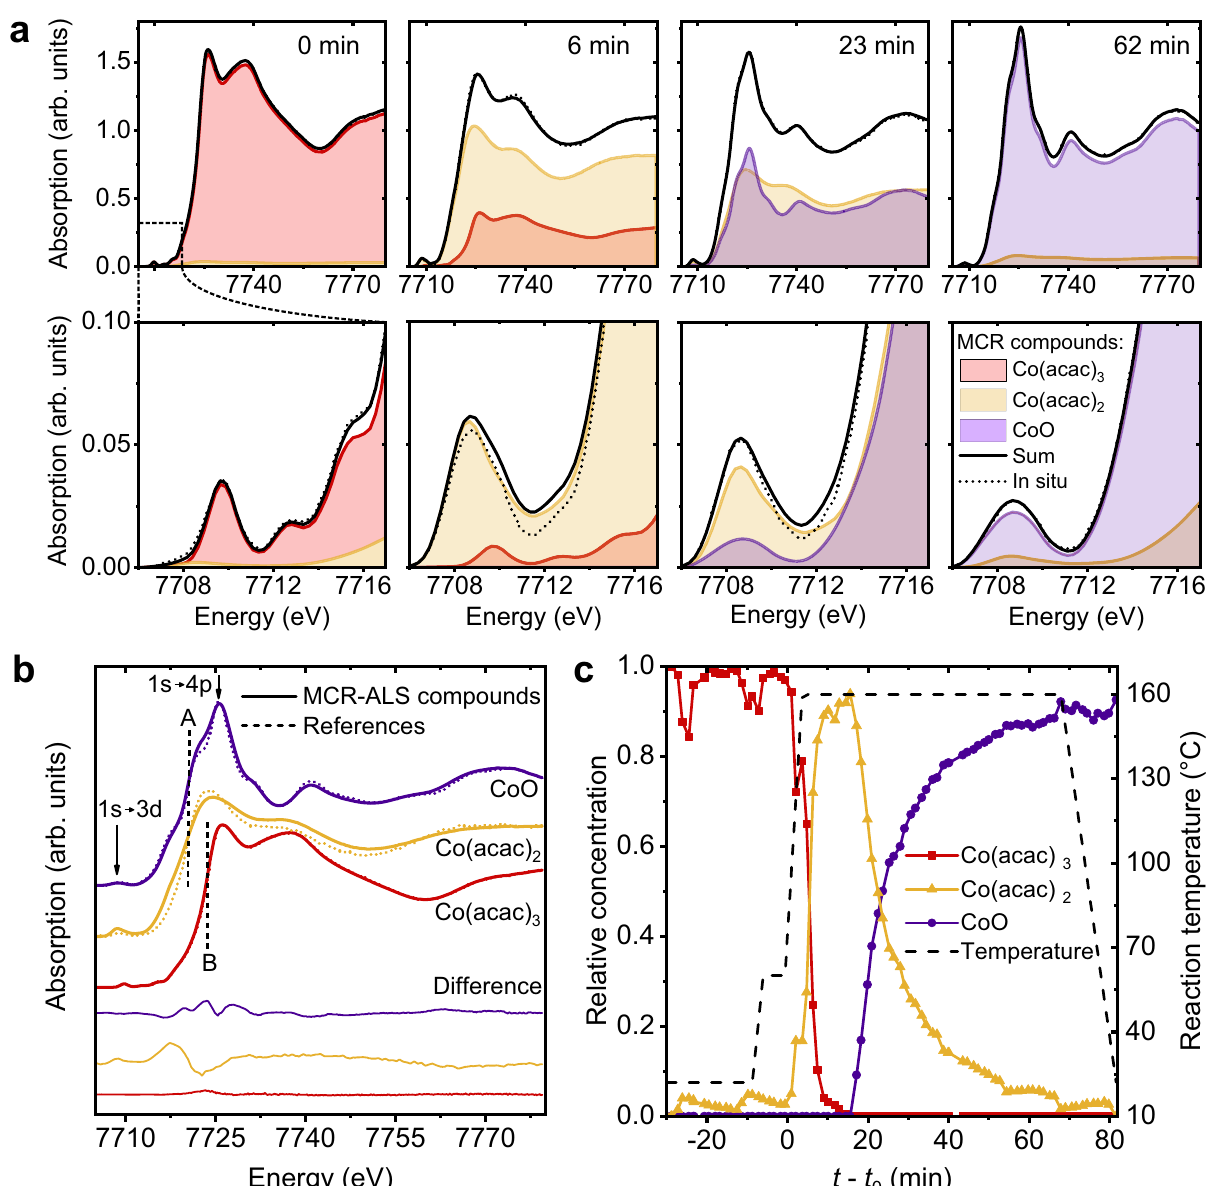
Fig. 2 Determination of chemical constituents from the in situ HERFD-XANES study and the MCR-ALS analysis. a Selected HERFD-XANES spectra of the time series with the main edge shown in the fi rst and the pre-edge in the second row. The spectra are plotted together with the multivariate curve resolution by alternating least squares (MCR-ALS) compounds recovered at the respective times. Linear combinations of the recovered spectra (black solid lines) match the in situ data (dotted lines). b Spectra of the recovered MCR-ALS compounds compared with measured reference spectra of Co(III) acetylacetonate (acac) dissolved in benzyl alcohol (red), Co(acac) 2 (orange), and CoO (violet). Dashed vertical lines emphasize the edge positions of Co 2 + ( “ A ” at 7720.2eV) and Co 3 + ( “ B ” at 7723.6eV). c Relative concentrations of the MCR-ALS compounds over reaction time. The dashed line indicates the temperature set point. We set t 0 (beginning of reaction time) to the point when we start heating to 160